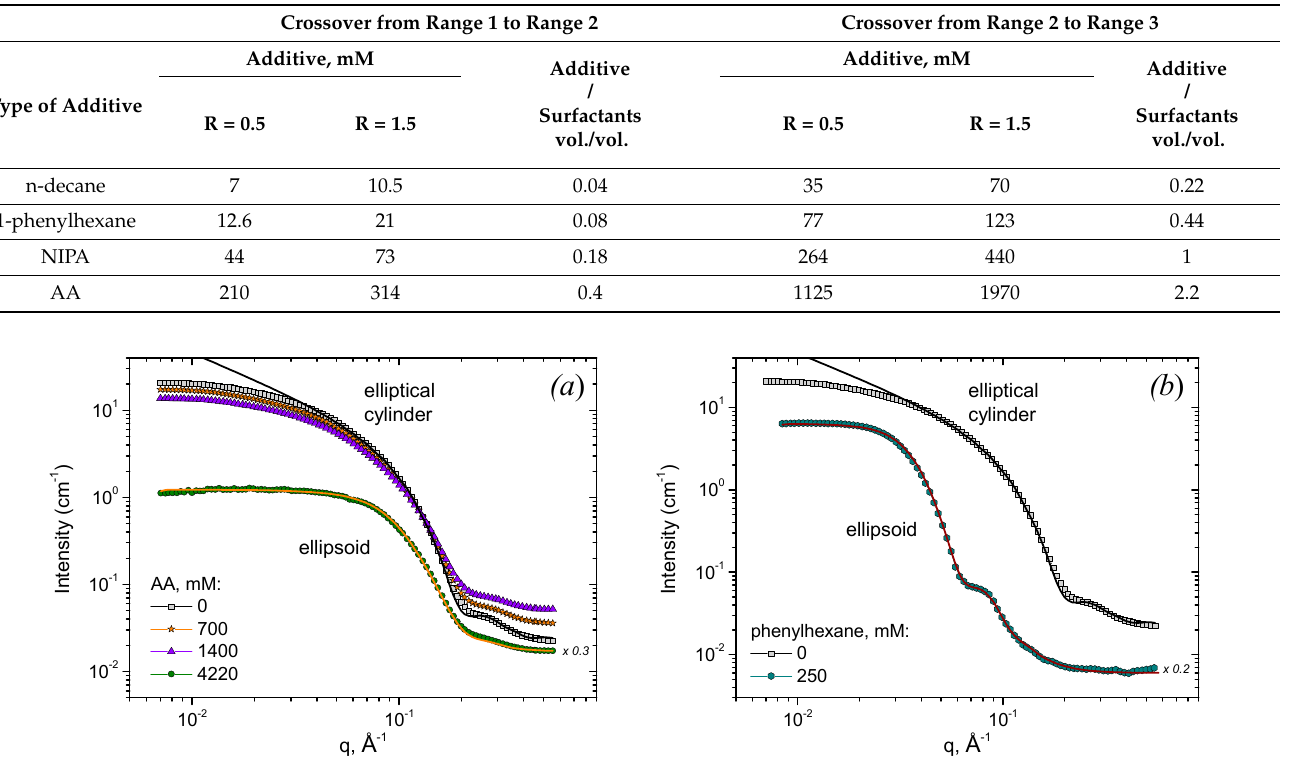
Figure 4. SANS scattering curves for aqueous solutions containing 78 mM potassium oleate, 117 mM C8TAB and different concentrations of AA ( a ) or 1-phenylhexane ( b ) indicated in the Figure. Solvent: KOH in D 2 O, pD 11.4. Temperature: 20 °C. Black line is a fit of experimental data with a model of elliptical cylinder. Orange and brown lines are fits with a model of charged prolate ellipsoid. For better representation, scattering curves for ellipsoids are offset by factors of 0.3 ( a ) and 0.2 ( b ). In the second range corresponding to intermediate additive concentrations, the vis- cosity drops sharply by 3–5 orders of magnitude down the water values (Figure 2b). This Table 2. Fitting parameters of SANS curves obtained from aqueous solutions containing 78 mM potassium oleate, 117 mM C8TAB and different additives (Figure 4). is accompanied by a disappearance of viscoelastic behavior (Figure 1, Figures S1 and S2), which indicates the disappearance of the entangled micellar network and transition to the on the mean micellar length as η ~L 1.9 [64]. Therefore, the drop in viscosity and breaking of tion of additives inside them. This is supported by a further decrease in the low-q SANS intensity in this range (Figure